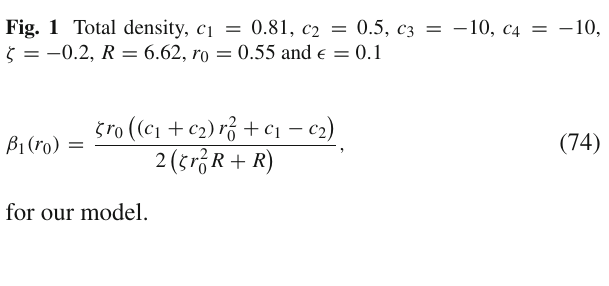
Fig. 2 Total radial pressure, c 1 = 0 . 81, c 2 = 0 . 5, c 3 = − 10, c 4 = = 0 . 55 and (cid:7) = 0 . 1 − 10, ζ = − 0 . 2, R = 6 . 62, r 0